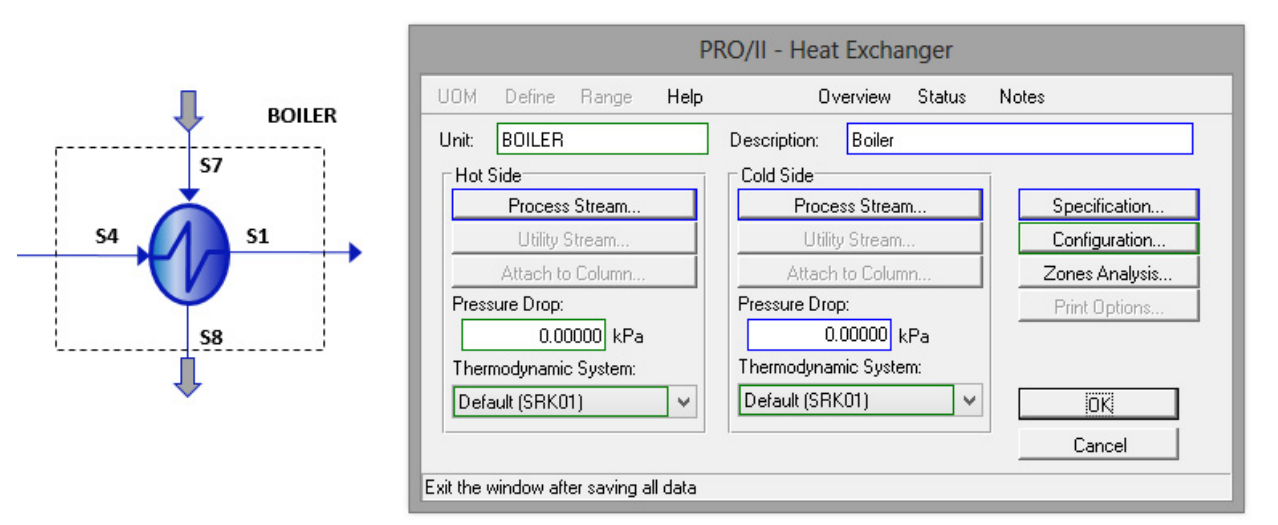
Figure 5. Boiler properties